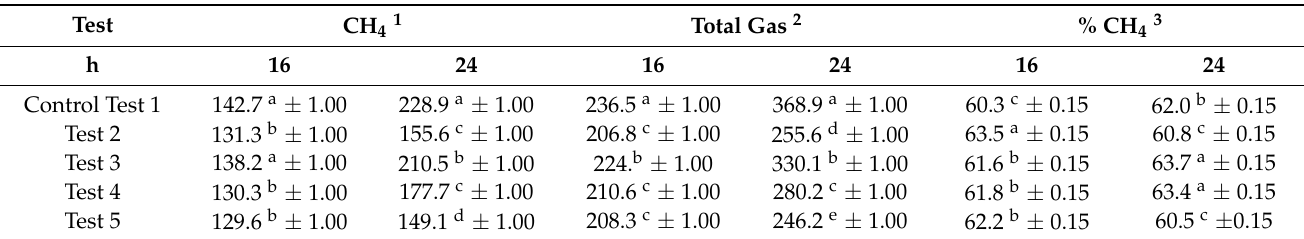
Table 5. Production of methane and total gas at 16 and 24 h. Different letters in the same column denote significant differences (a,b,c,d,e p ≤